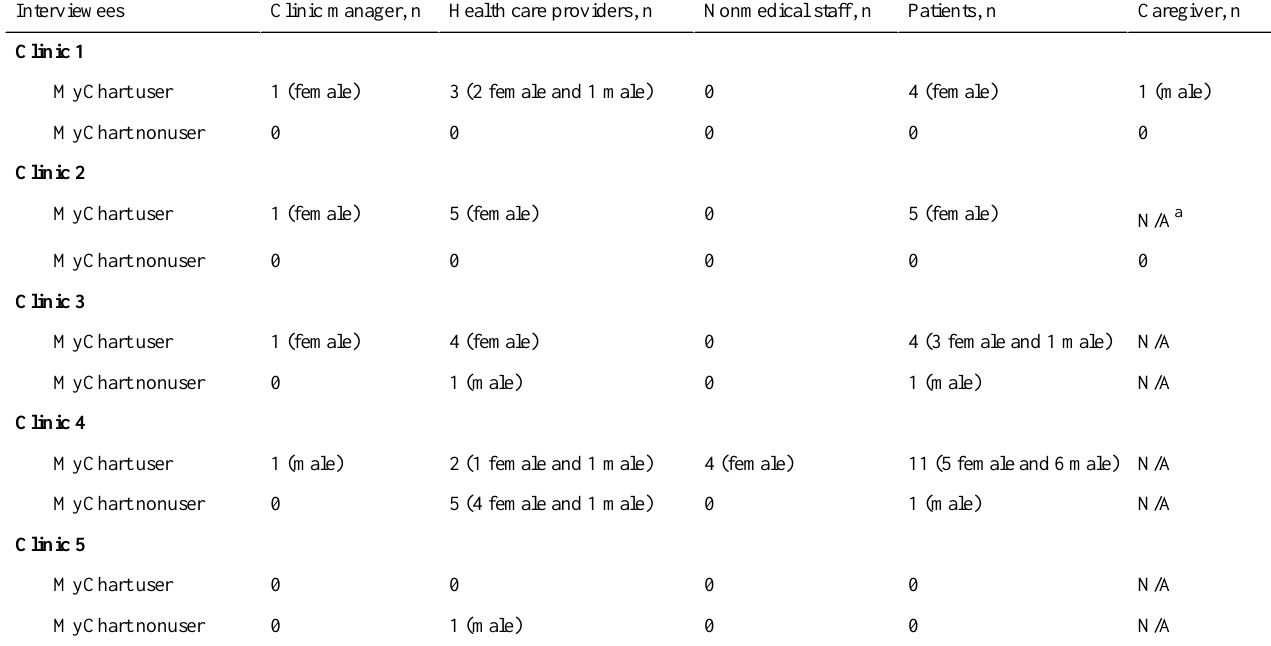
Table 4. Interviewed participants per